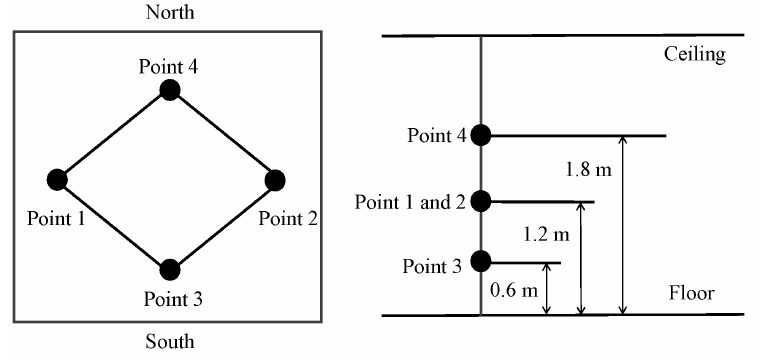
Figure 7. Location of experimental apparatus arranged in the test room. Table 3. Experimental apparatus with measuring range and accuracy.